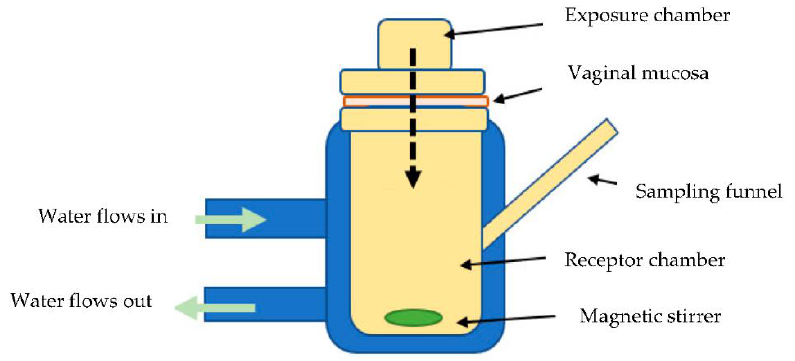
Figure 1. Schematic diagram of Franz diffusion cell.